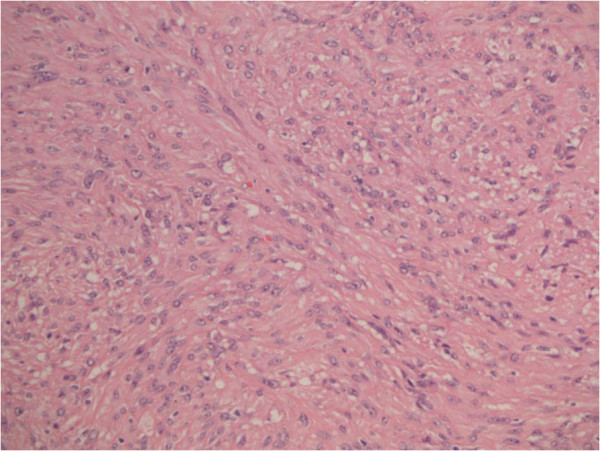
Stromal tumor composed of spindle and epithelioid cells with focal vacuolar (signet ring) change. (E & E, 20×).